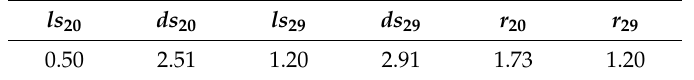
Table 2. Main dimensions of the matching and stop-band filter structure (in